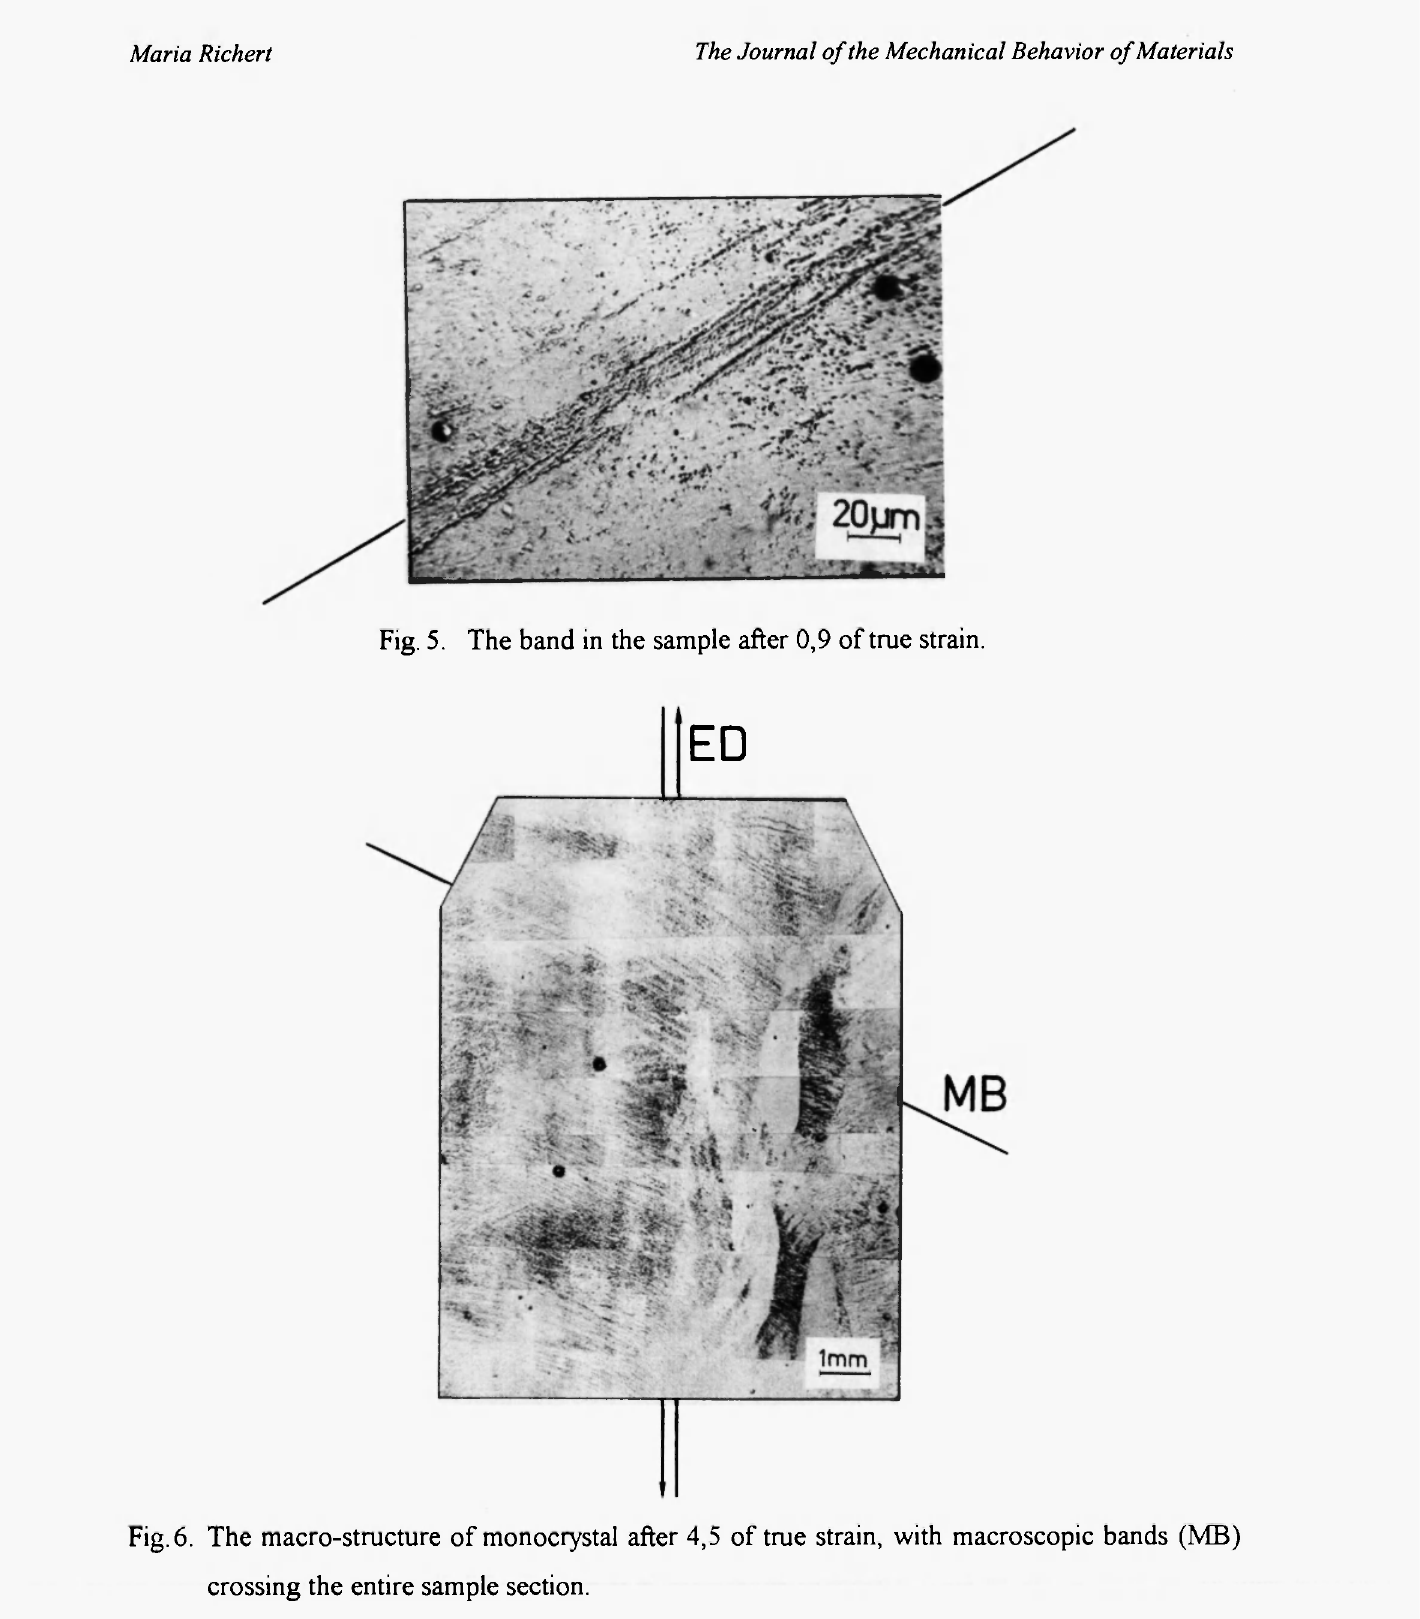
Fig. 6. The macro-structure of monocrystal after 4,5 of true strain, with macroscopic bands (MB) crossing the entire sample